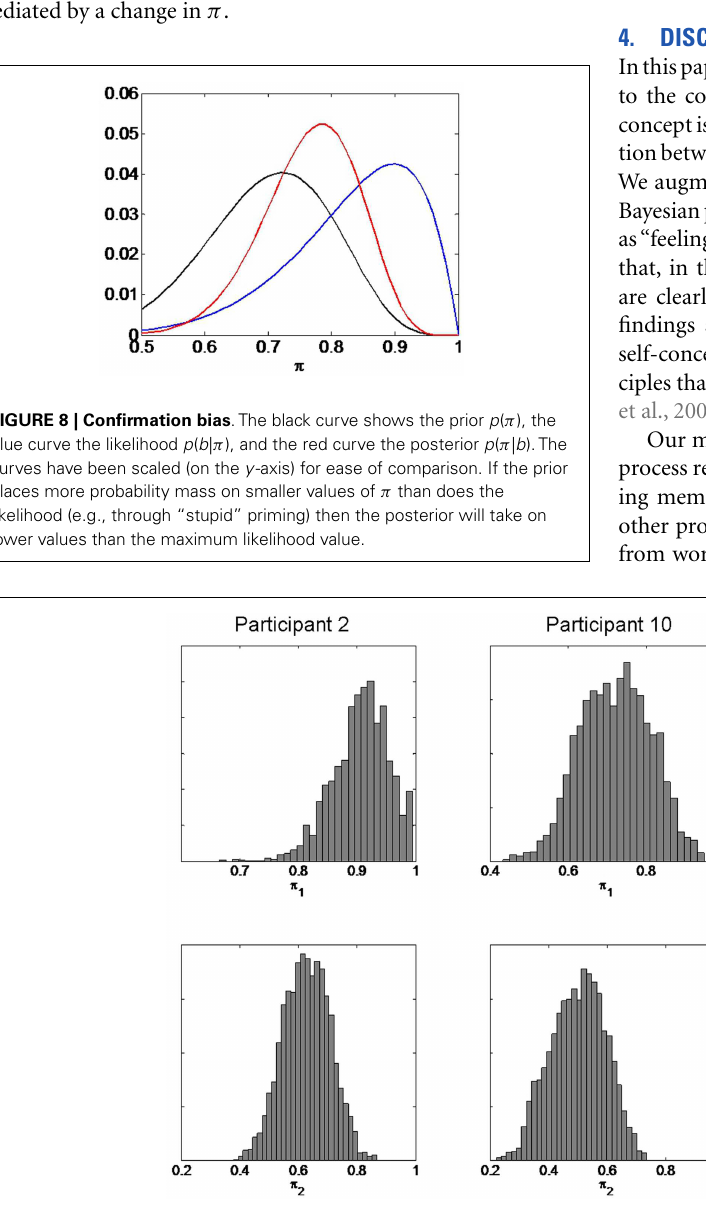
FIGURE 9 | Estimated model parameters from individual subject data .The figure shows the posterior densities p ( π 1 | b , y ) (top row for session 1) and p ( π 2 | b , y ) (bottom row for session 3) for three